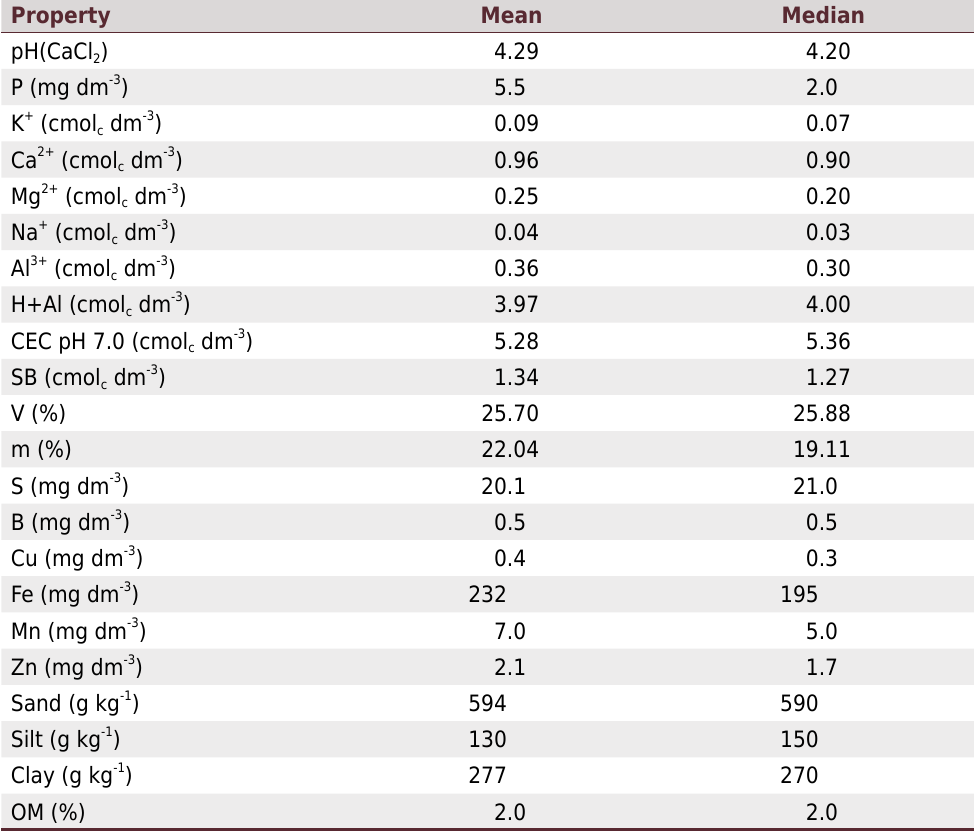
Table 1. Chemical properties and particle size of soil samples (0.00-0.20 m)